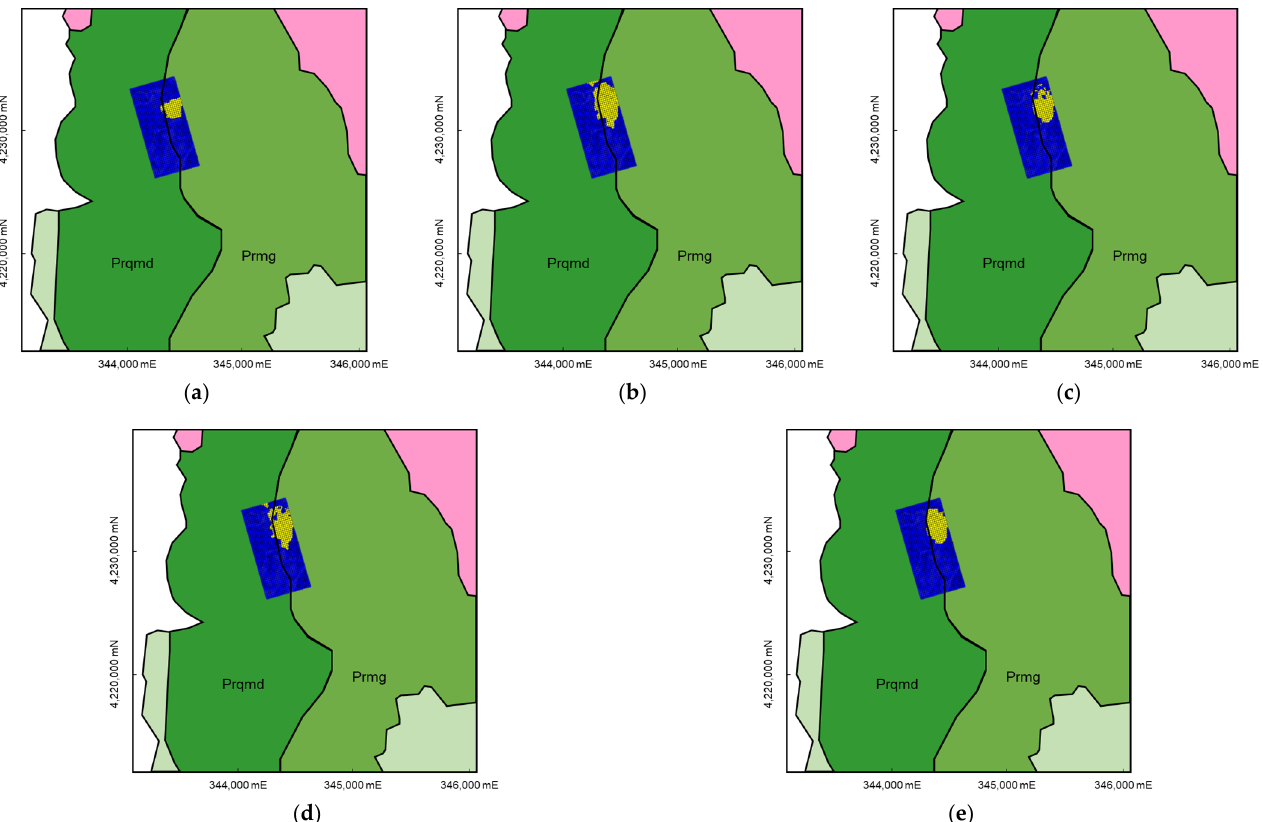
Figure 8. Comparison between the geological map and classification results obtained with trained ML methods: ( a ) SVM, ( b ) RF, ( c ) XGB, ( d ) LGBM and ( e ) DNN. The areas colored in yellow are candidates for ore deposits.